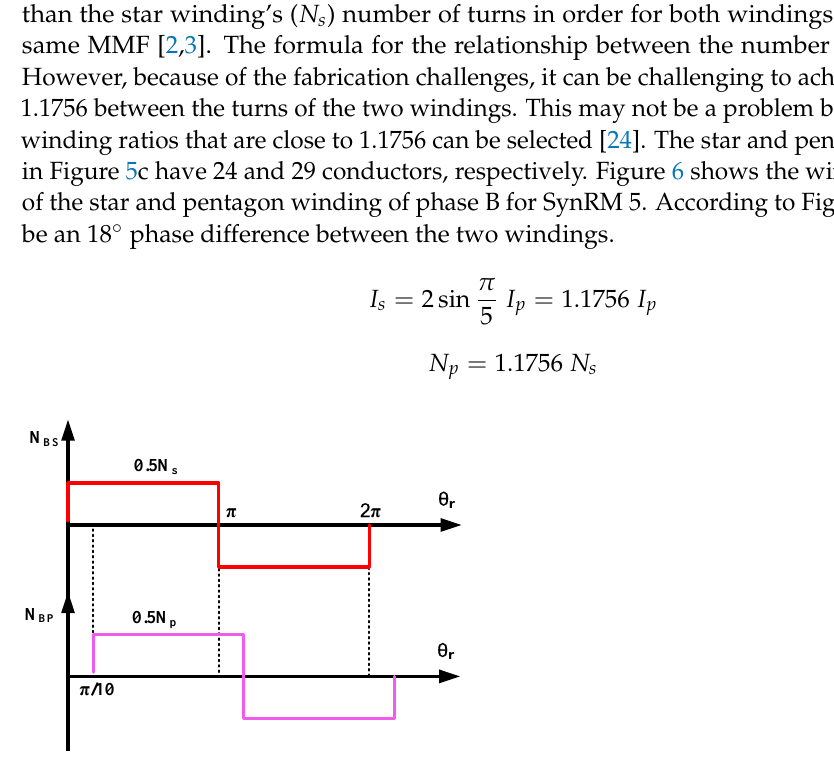
Figure 6. The winding functions for the star and pentagon windings of phase B.